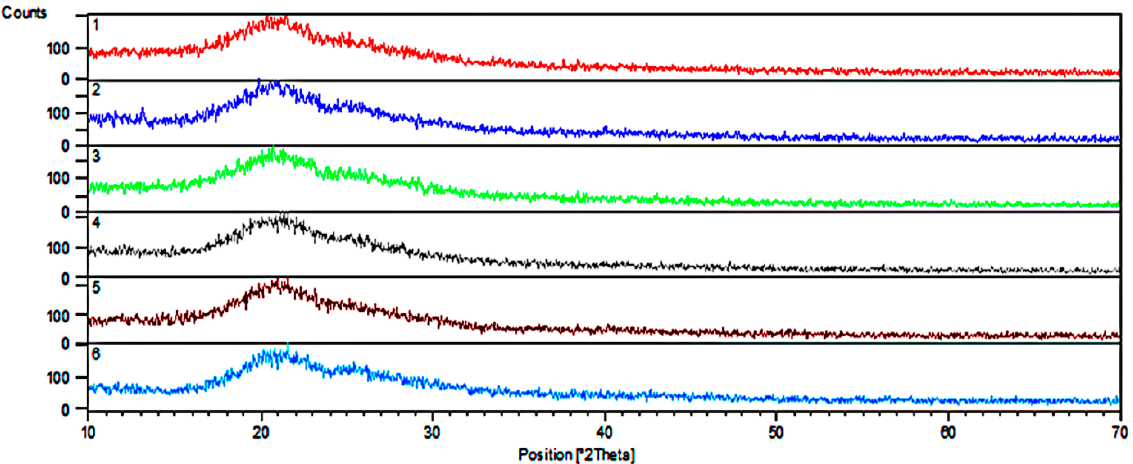
Figure 3. XRD patterns of the gels. Samples identification in accordance with Table 1.